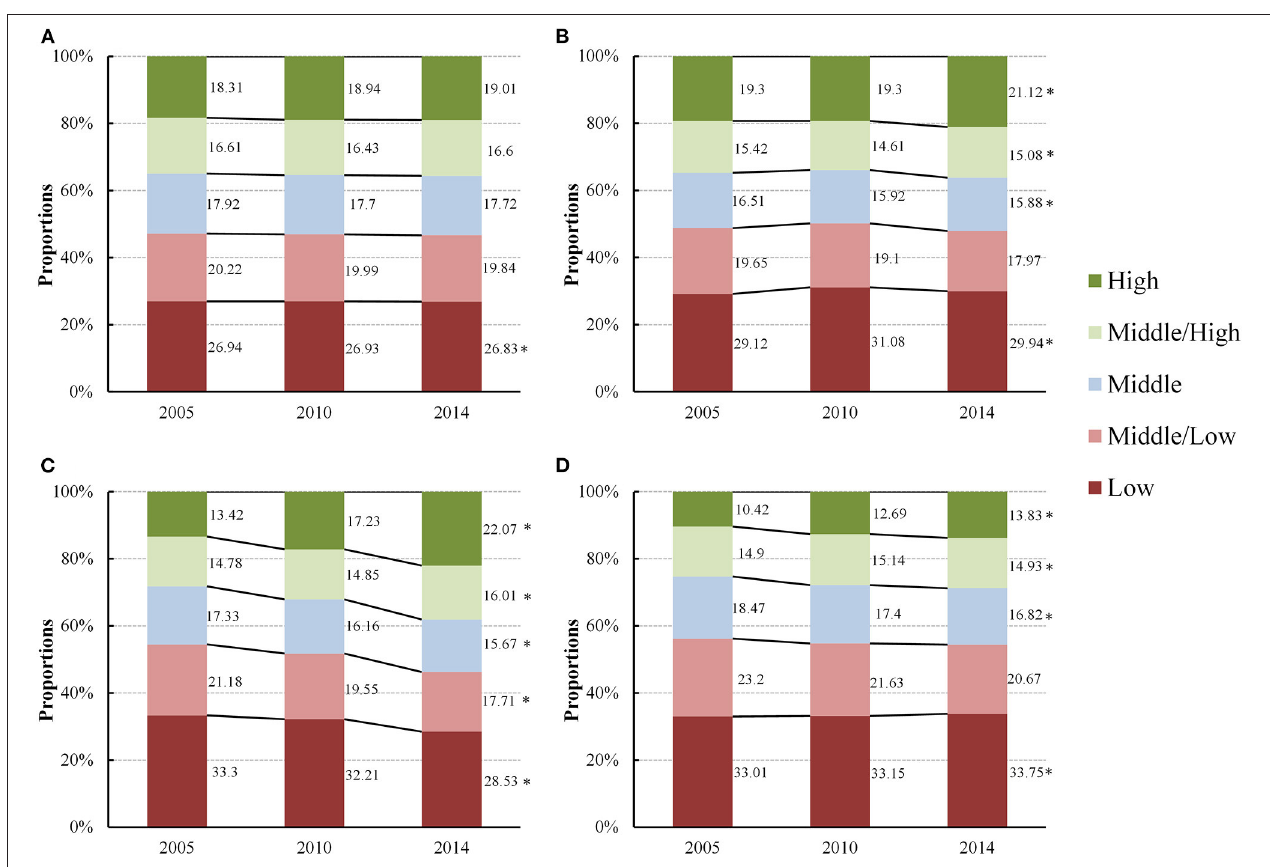
FIGURE 2 | Proportions of change in different levels of physical fitness, as indexed by physical fitness index, in children and adolescents by age groups [ (A) 7–9 years, (B) 10–12 years, (C) 13–15 years and (D) 16–18 years] from 2005 to 2014 (2005–2014, China). * A statistically significant increased trend or decreased trend in the proportions of each level of physical fitness from 2005 to 2014 ( P trend < 0.05) using Cochran-Armitage trend